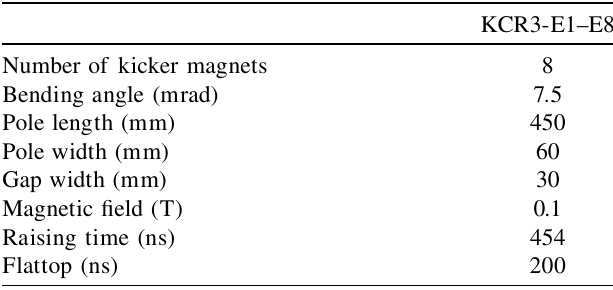
TABLE IX. Parameters of kicker magnets used to estimate the fast-extraction system of the